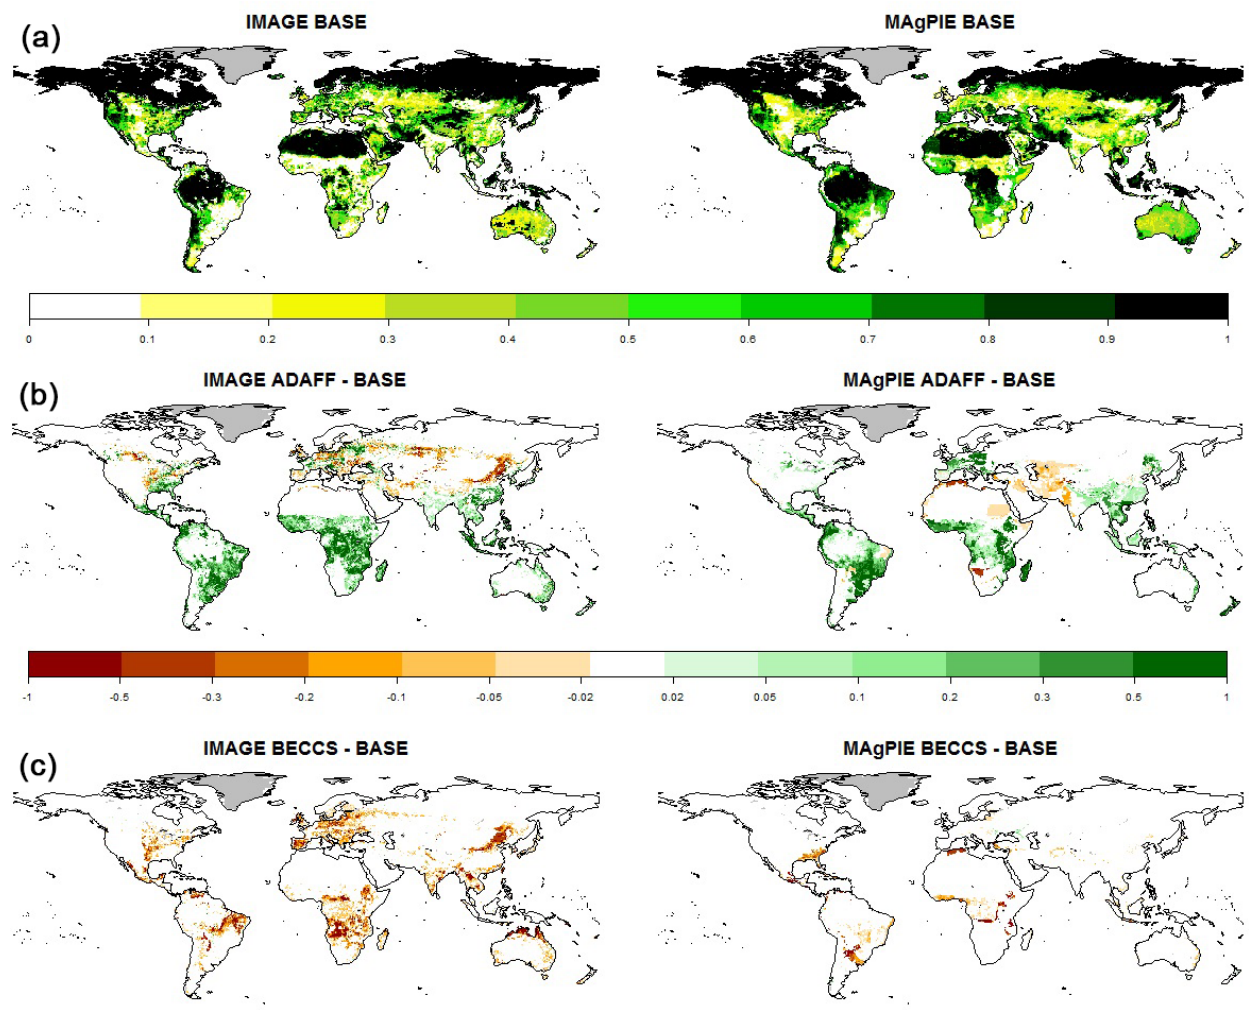
Figure 2. (a) Fraction of grid cell under natural vegetation (including afforested area but not degraded forests) by the end of the century (2090–2099) in the BASE scenario for IMAGE (left) and MAgPIE (right). (b) Difference in the natural vegetation fraction between the ADAFF and the BASE scenario by the end of the century (2090–2099). (c) Same as panel (b) but between the BECCS and the BASE